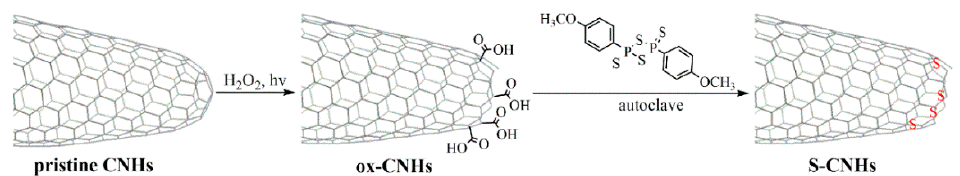
Figure 1. Illustrative preparation of